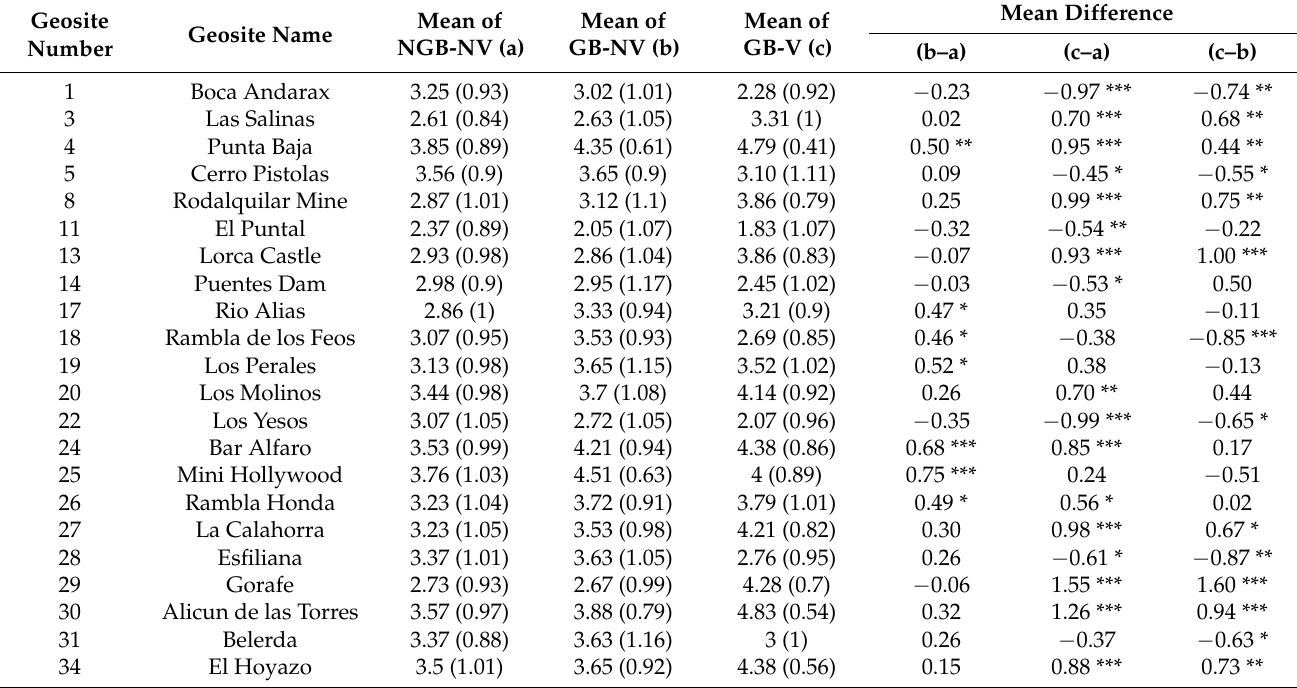
Figure 8. ( a – d ) Boxplots of scenic beauty rating by respondents, grouped following their geoscience background and field visits (NGB-NV = no geoscience background no visit to geosites, 104 persons; GB-NV = geoscience background and no visit to geosites, 43 persons; GB-V = geoscience background and visit to geosites (29 persons), for different geosite clusters: LG-VP = local geo-feature and viewpoint, 13 geosites; HE-VP = human–environment interaction feature and viewpoint, 10 geosites; HE-LG-VP = human–environment interaction feature, local geo-feature and viewpoint, 4 geosites; LG = local geo-feature, 5 geosites; HE = human–environment interaction feature, 2 geosites). See Table A2 in Appendix A for the list of clustered geosites. The scientific value rating was done by the GB-V group (29 persons). Both scenic beauty and scientific value were rated on a 1–5 scale (see Tables A4 and A5 in Appendix A for their mean ratings). Table 2. Pairwise multiple comparisons of mean scenic beauty ratings (standard deviations in parentheses) of the 22 in- dividual geosites (where a significant difference in mean scenic beauty rating was found) by the three groups, grouped following their geoscience background and field visits: NGB-NV = no geoscience background and no visit to geosites; GB-NV = geoscience background and no visit to geosites; GB-V = geoscience background and visit to geosites. Scenic beauty rated on a 1–5